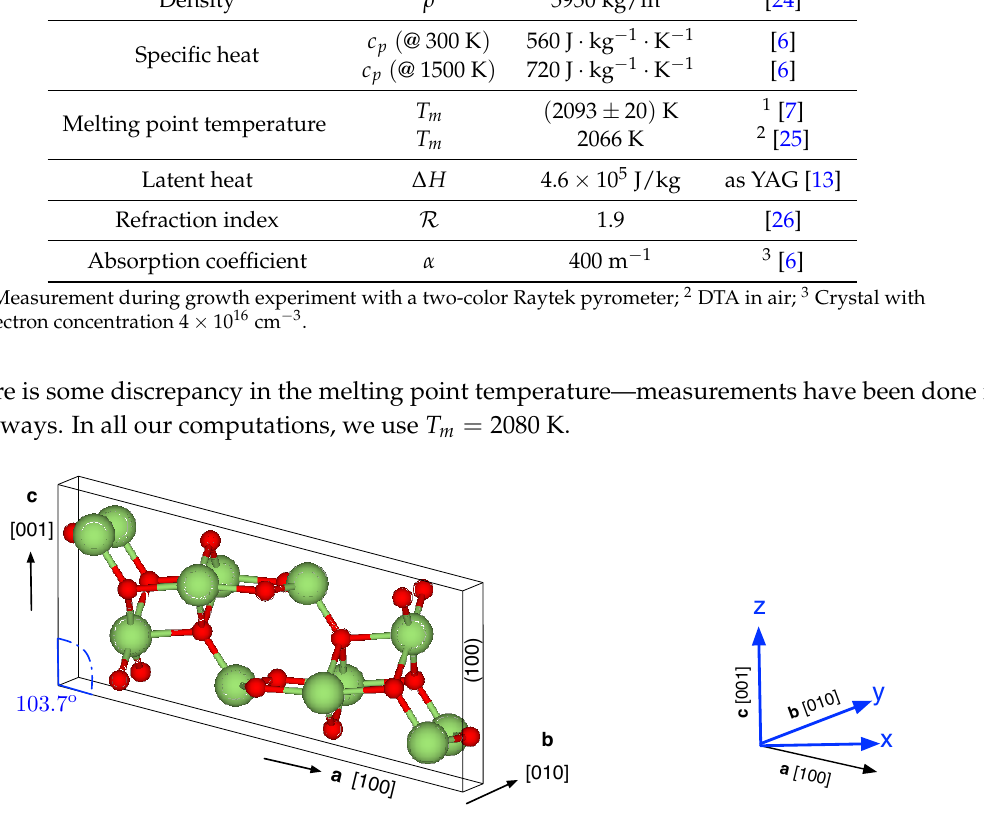
Figure 1. Unit cell of β -Ga 2 O 3 ( left ) and standard coordinate system ( right ). Ga atoms in green (large) and oxygen ones in red (small). The figure is drawn with VESTA